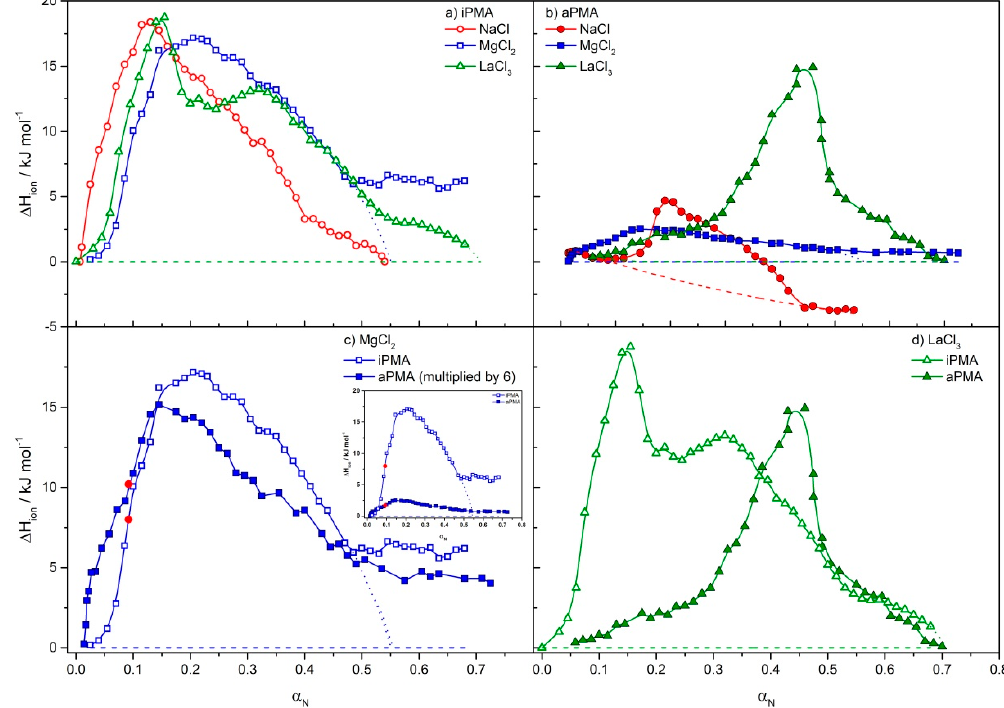
Figure 1. Ionization enthalpies ( Δ H ion ) in dependence on α N for ( a ) iPMA and ( b ) aPMA ( c m = 1 g·L − 1 ) in aqueous solutions of NaCl, MgCl 2 and LaCl 3 with I = 0.01 mol·L − 1 at 25 °C; ( c ) comparison of calorimetric curves for iPMA and aPMA in 0.00333 M MgCl 2 ; the Δ H ion values for aPMA are inhere multiplied by 6 (the inset in Figure 1c shows comparison of the original Δ H ion values). The red circles in these curves indicate α N at which the solution became opaque in the direction of decreasing α N ; ( d ) comparison of calorimetric curves for iPMA and aPMA in 0.00167 M LaCl 3 . The solid lines are best fits of the experimental data and are used merely to lead the eye. The red, blue and green dashed lines in ( a – d ) are the base lines used for the integration of the peaks (see text). Table 2. Values of the transition enthalpies ( Δ H tr ) of iPMA and aPMA ( c m = 1 g·L − 1 ) in aqueous NaCl,